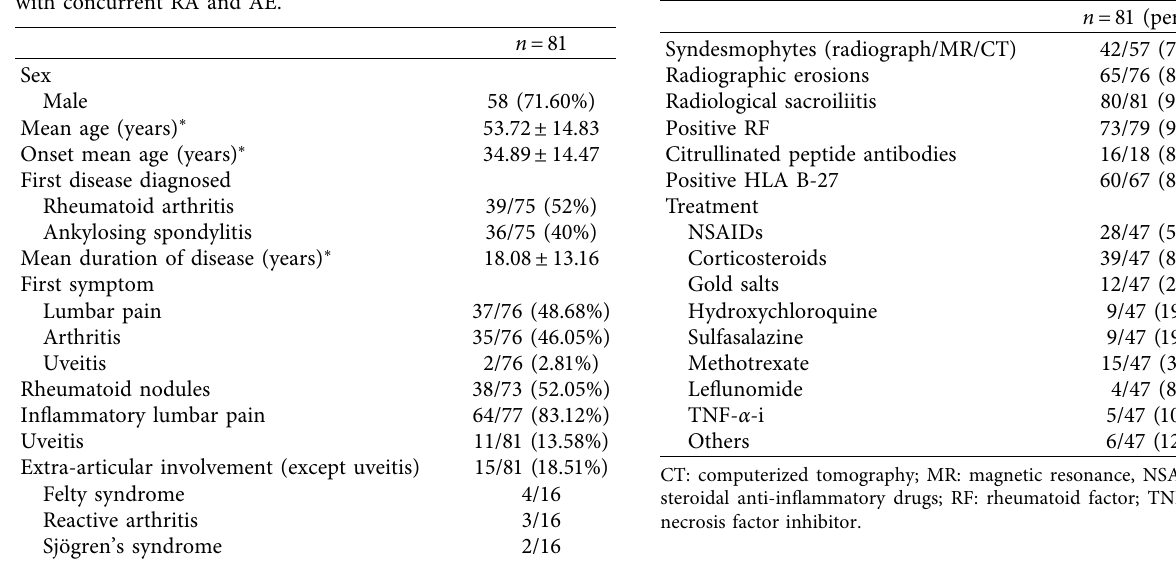
Table 3: Radiological, laboratory, and treatment